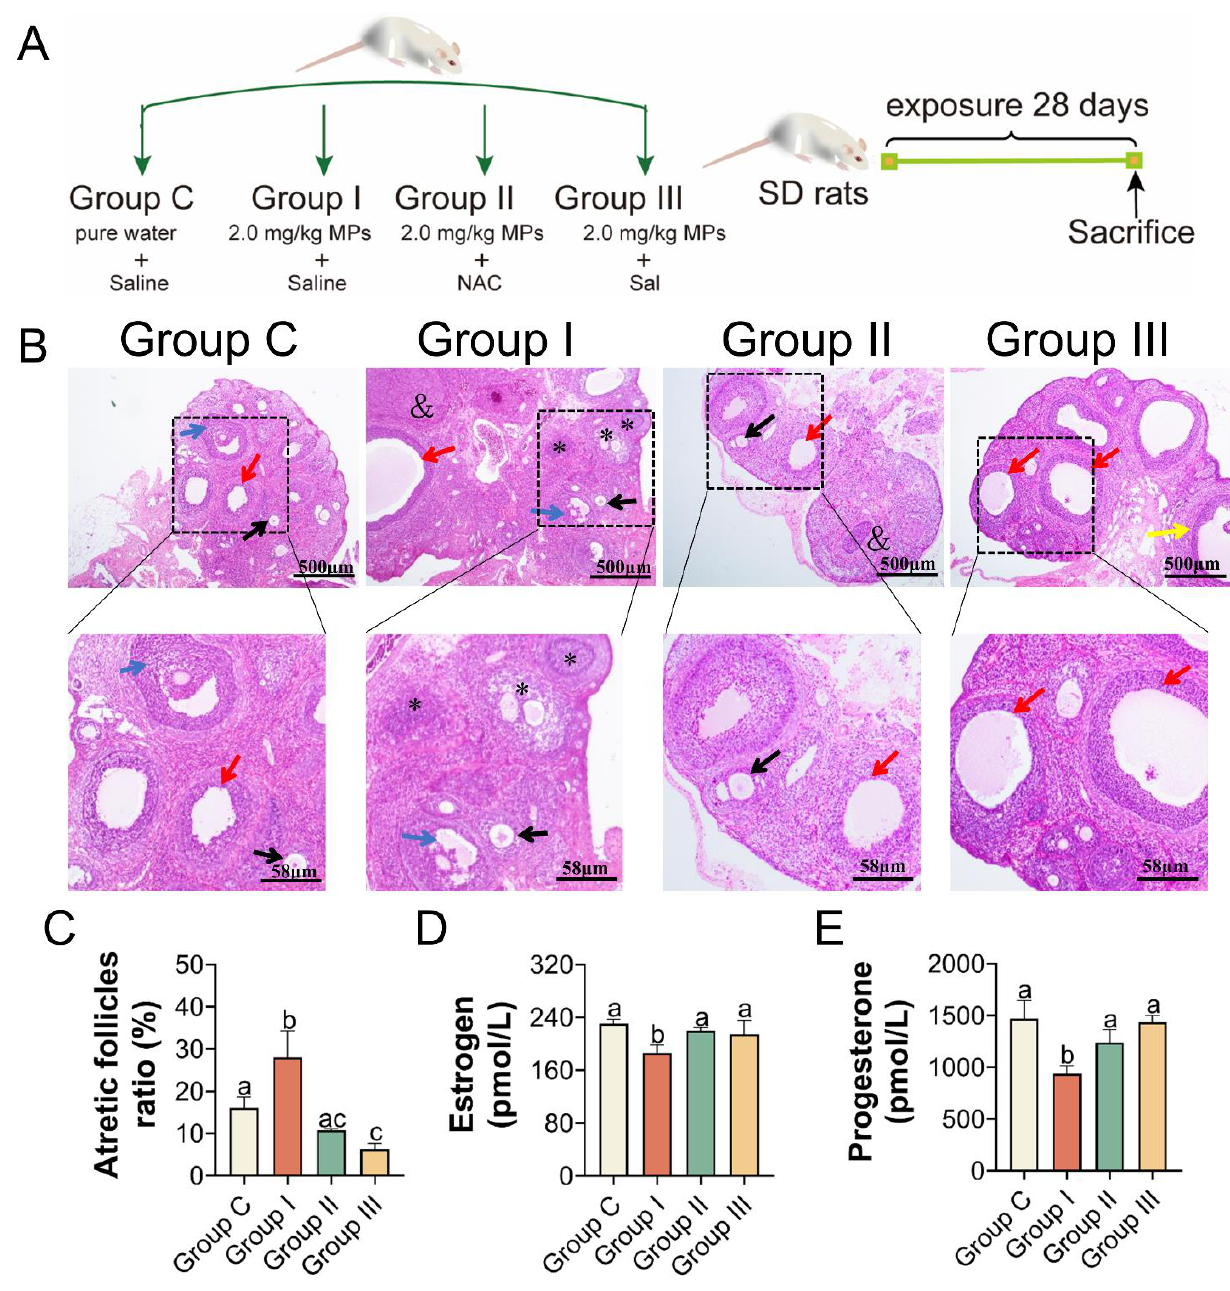
Figure 5. The effects of NAC and Sal treatment on atretic follicles ratio, serum hormone levels. ( A ) Format of the trial, groups, and interventions. ( B ) H&E staining in ovarian slices (black arrow: primary follicles, red arrow: cystic follicles, blue arrow: secondary follicles, yellow arrow: antral follicles, asterisk: atretic follicles, and: corpus luteum), n = 5 per group. ( C ) Atretic follicles ratio, n = 5 per group. ( D , E ) ELISA was used to assess the amount of estradiol and progesterone in serum. The information was presented as the mean ± SD. Different letters indicate significance.